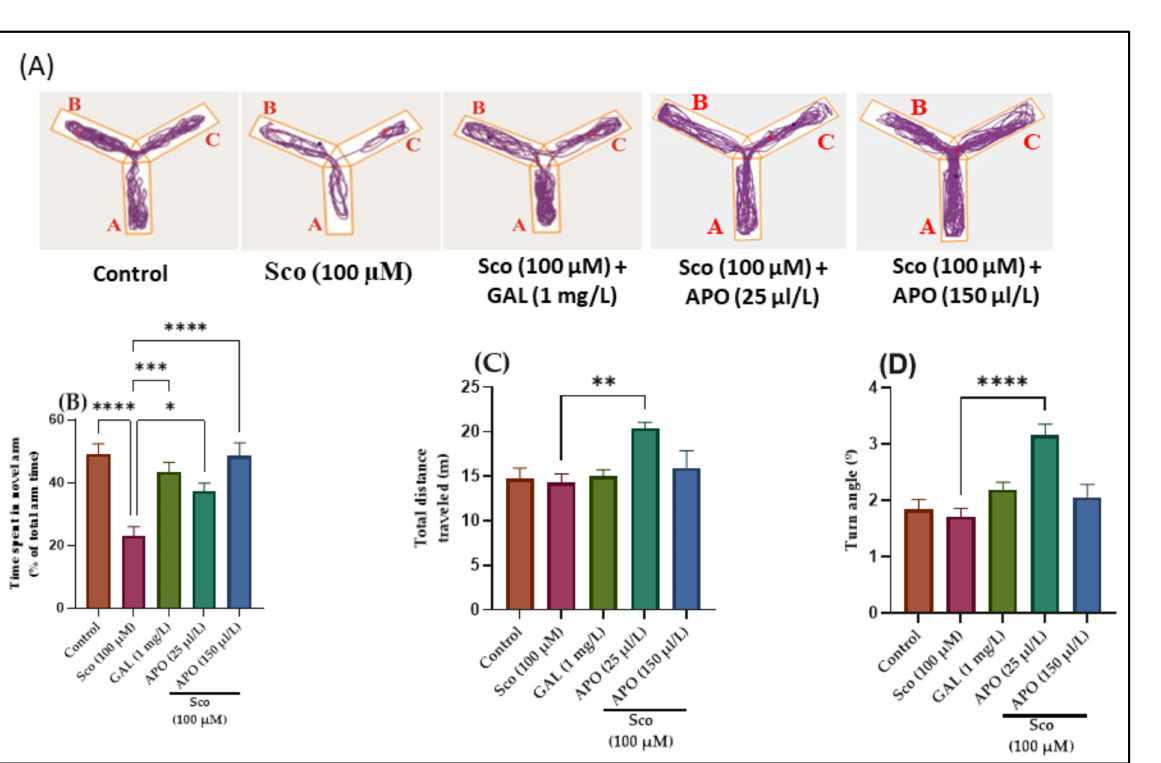
Figure 2. Y-maze results for Angelica purpurascens essential oil (APO: 25 and 150 µ L/L). ( A ) Rep- resentative tracking locomotion patterns; ( B ) Time spent in the novel arm (% of total arm time); ( C ) Total distance traveled (m); ( D ) Turn angle ( ◦ ). Data are presented as means ± S.E.M. ( n = 10). * p < 0.01, ** p < 0.001, *** p < 0.0001, and **** p < 0.00001 (Tukey’s post hoc analyses). Galantamine (GAL, 1 mg/L) was used as reference positive